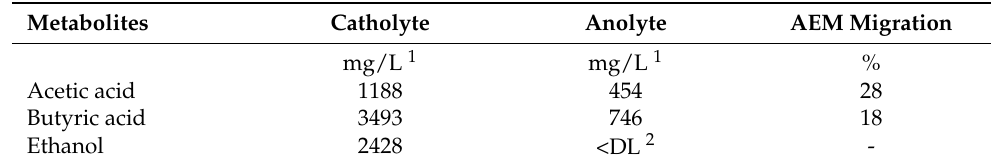
Table 5. Metabolic products from the IBH 2 S (stage